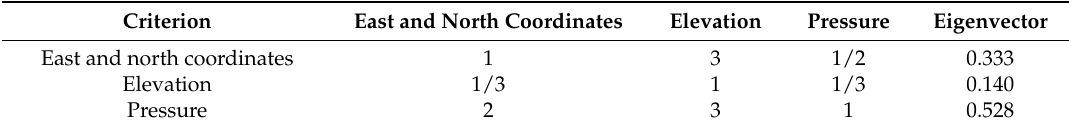
Table 5. Pairwise comparison matrix, expert 1.